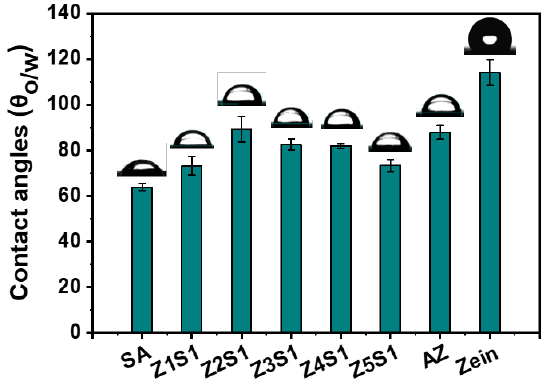
Figure 4. The surface wettability of ZS particles with different ratios.